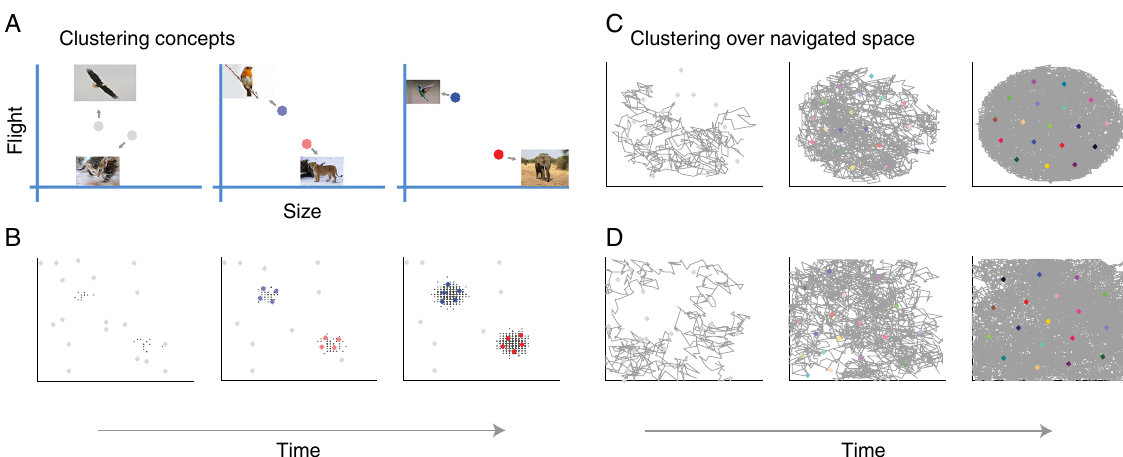
Fig. 1 Cluster learning applied to conceptual and spatial examples. a The most similar cluster moves (i.e., adjusts its tuning) toward its newest member and becomes associated with a response (blue for bird, red for mammal). b Out of a pool of many randomly tuned clusters, a subset comes to represent the two concepts over learning. c , d The same learning system applied to an agent locomoting in a circular or a square environment gives rise to a hexagonal cluster organization. How the stimulus space is sampled affects how clusters are distributed in the representational